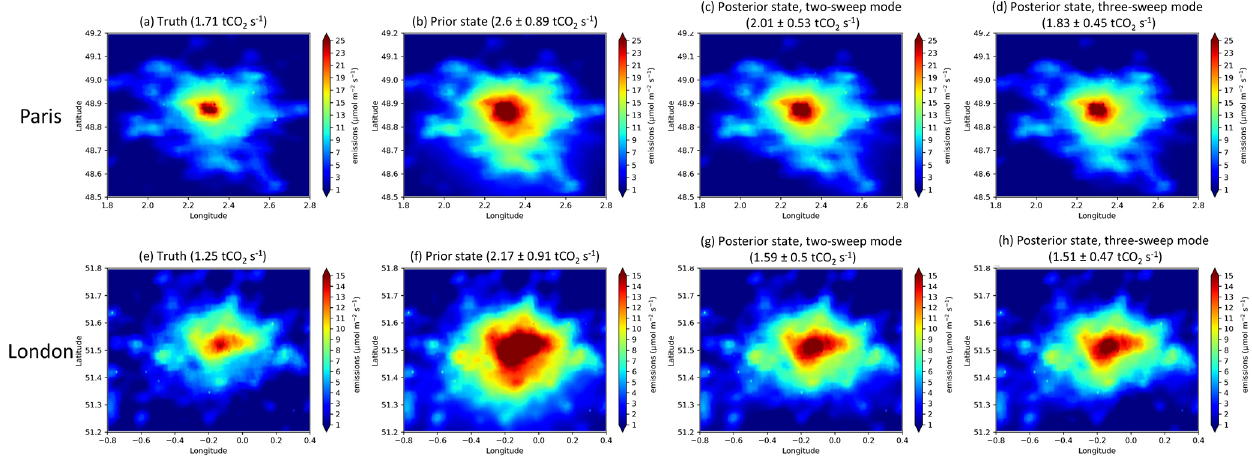
Figure 4. Truth, prior state, and posterior state based on the cloud-free samplings of the two-sweep and three-sweep modes in Paris (a–d) and London (e–h) at 12:00UTC on 15 April 2018. The values in parentheses are the total CO 2 emissions within the domain and its uncertainty.